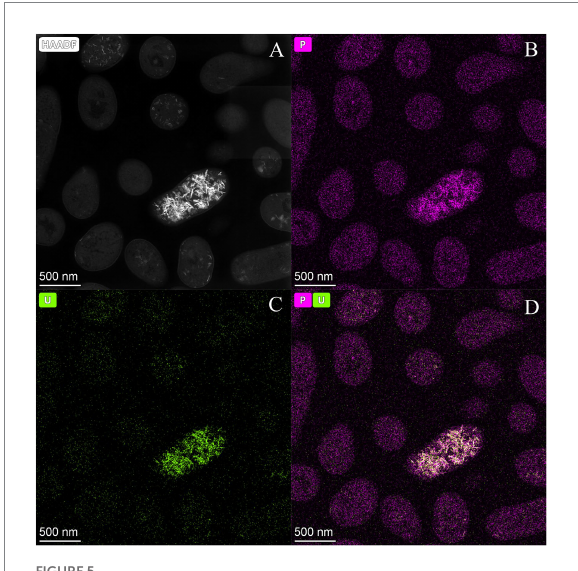
FIGURE 5 High angle annular dark-field-scanning transmission electron microscopy (HAADF-STEM) image of Microbacterium sp. Be9 cells after incubation under MC2 condition (A) ; EDX element mapping for P (B) , U (C) and P–U combined (D) .